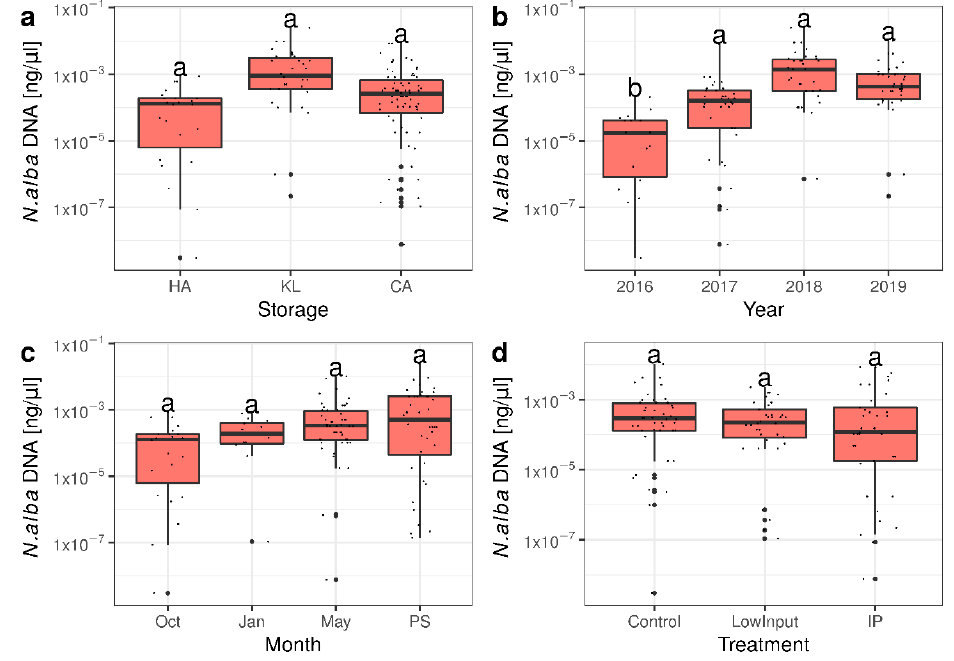
Figure 6. Quantitative analysis of Neofabraea alba DNA with the samples used for the metabarcoding study. The absolute amount of N. alba DNA measured by qPCR follows very similar patterns to those measured by metabarcoding for the variables ( a ) storage technology, ( b ) growing year, ( c ) duration of storage, and ( d ) plant protection treatment. The differences between the variables of storage, month and treatment are not significant but trends are visible. Letters denote significance as calculated in Kruskal–Wallis tests with Fisher post hoc tests .